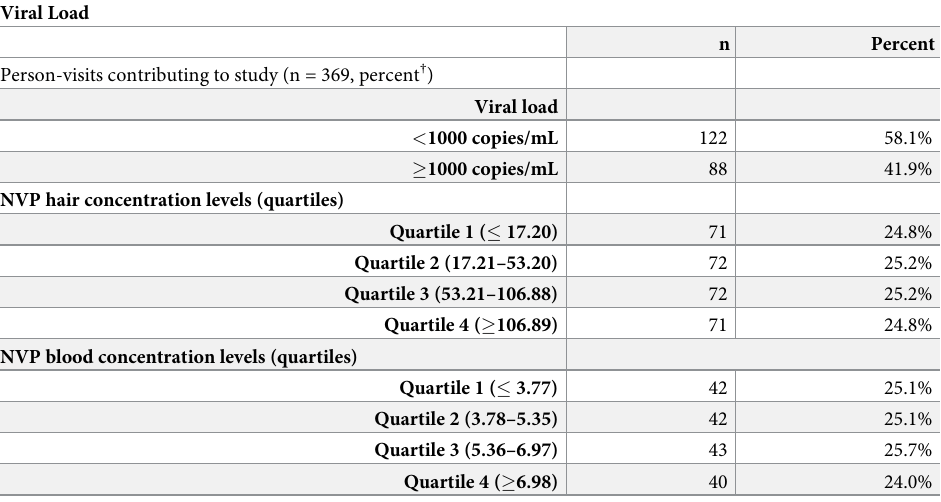
Table 2. Viral load and nevirapine concentration quartiles in hair and plasma. Viral